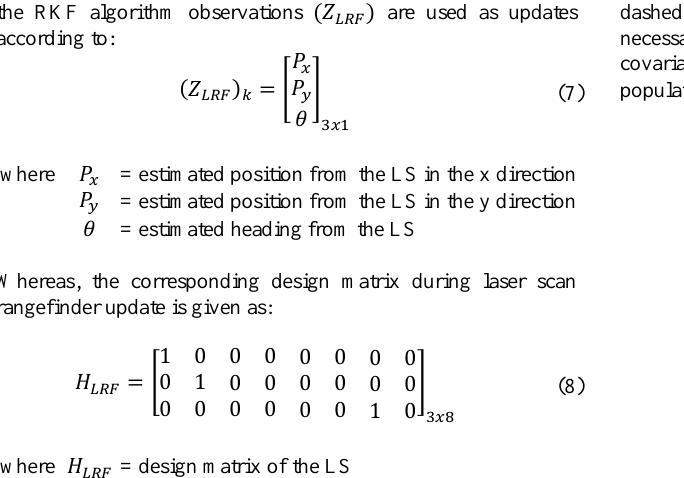
Figure 5. Confidence ellipse in